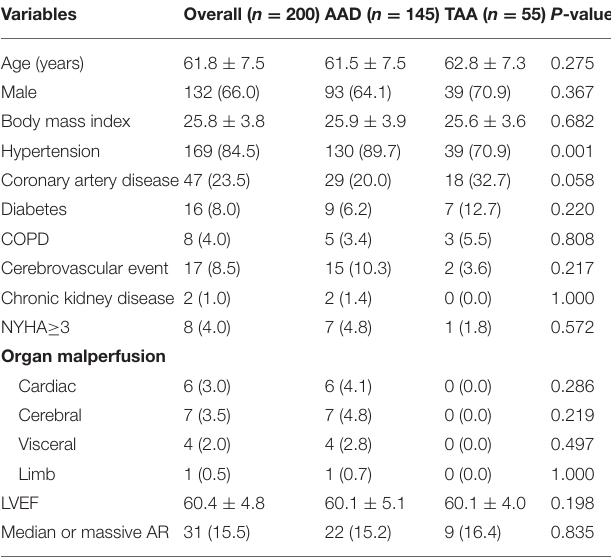
TABLE 1 | Preoperative